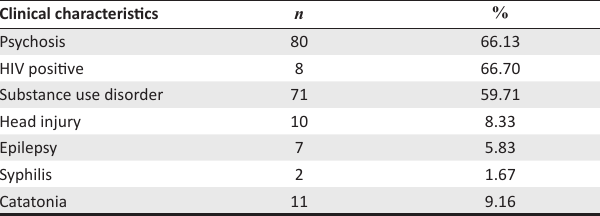
TABLE 1: Clinical characteristics of patients ( n = 125).